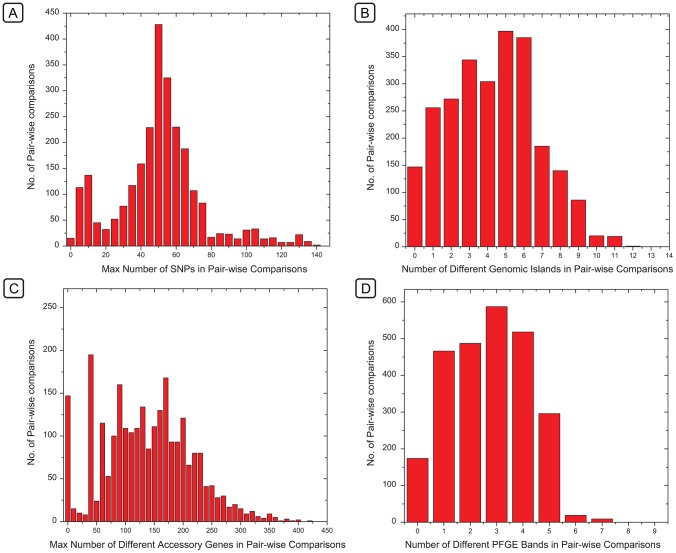
Histograms of the frequencies of numbers of differences between pairs of genomes in SNPs, genomic islands, accessory genes, or PFGE bands.Histograms of the frequencies of numbers of differences between pairs of genomes in SNPs (A), genomic islands (B), accessory genes (C), or PFGE bands (D). The X axes of histograms A and C indicate the maximal number of differences within the indicated ranges in order to ensure that the first column only includes identical pairs (maximum = 0). These frequency distributions correspond to the same data which were used for comparisons in Figure 8, except that those referred to genetic similarity and the data here refer to the converse, which are differences.